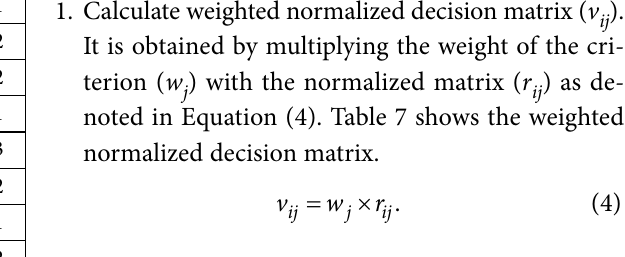
Table 7. Weighted normalized decision matrix (v